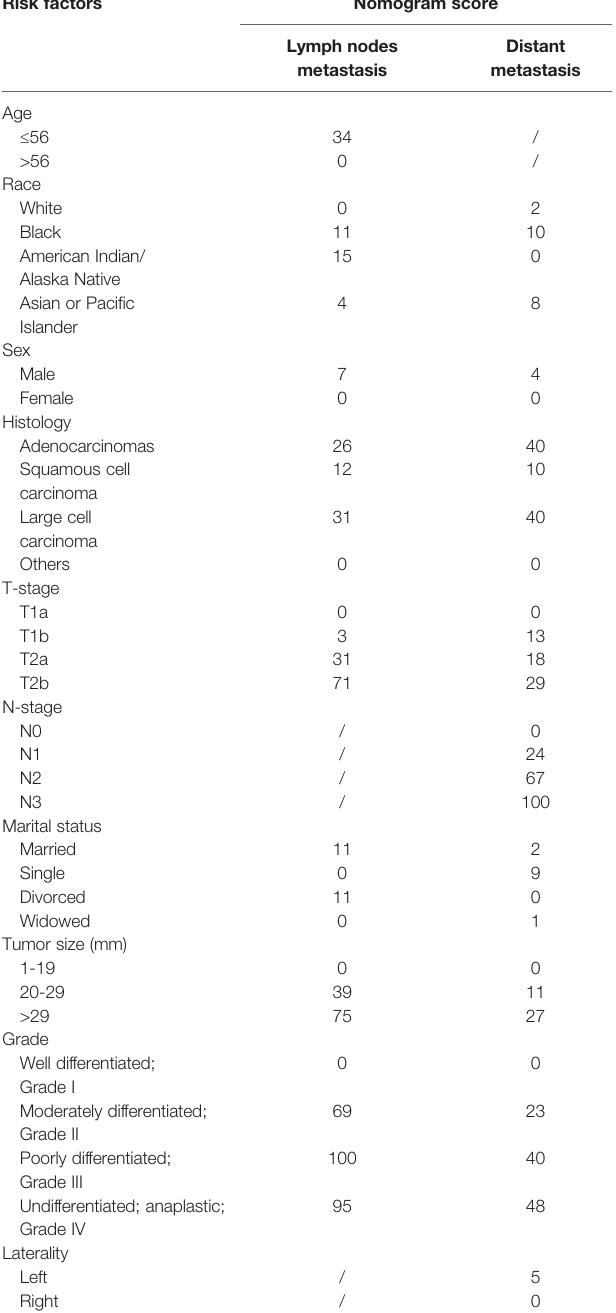
TABLE 5 | Nomogram score of risk factors for LNM and DM in T1-2 NSCLC.